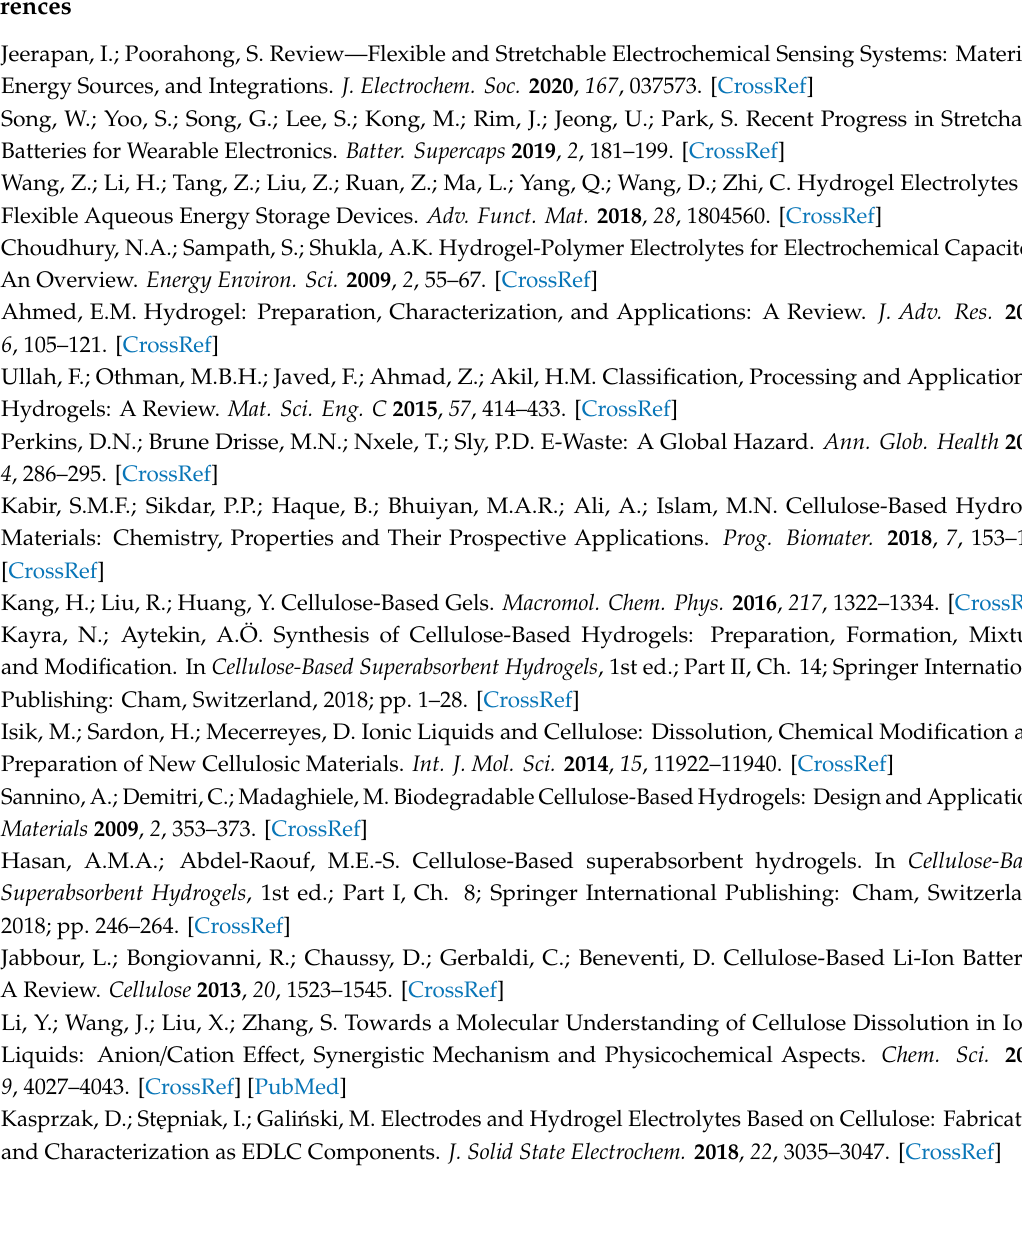
hydrogel at di ff erent applied potentials. Table S2: Color coordinates of ECDs comprising optimized self-standing cellulose-based EC hydrogel at bleached (o ff ) and colored states ( − 2.4 V). Table S3: Bending test of flexible ECDs: transmittance (%) at 550 nm and transmittance changes ( ∆ %T) of flexible ECDs comprising optimized cellulose-based hydrogel before and after bending test (50